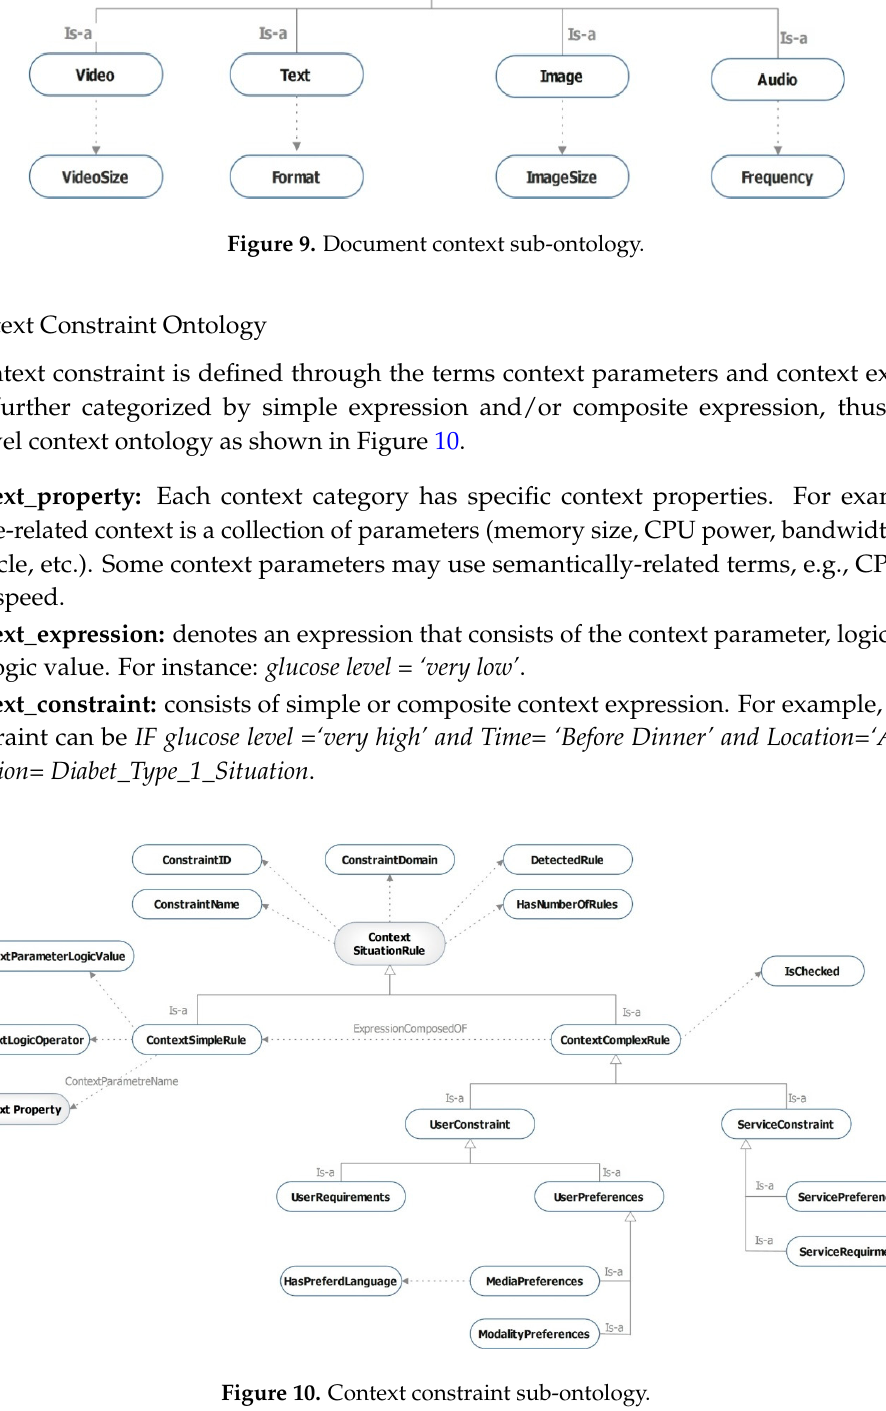
Figure 10. Context constraint sub ‐ ontology.